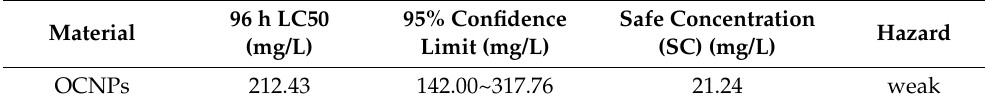
Figure 4. Effect of different concentration OCNPs on the mortality of Zebrafish. Table 2. The 96 h LC 50 values for zebrafish after exposure to